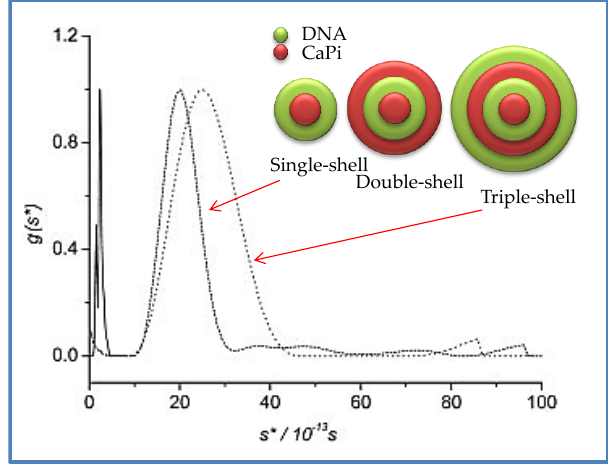
Figure 9. CaP/DNA nanoparticles with encapsulation of DNA by deposition of successive CaP layers, and their sedimentation coefficient distributions. Adapted from [121], John Wiley & Sons, Inc., 2006.